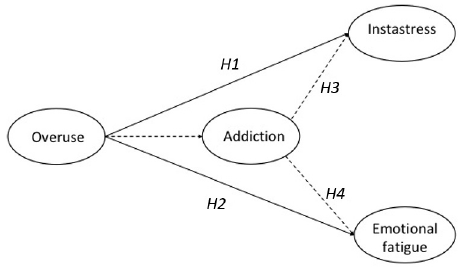
Figure 1. Theoretical